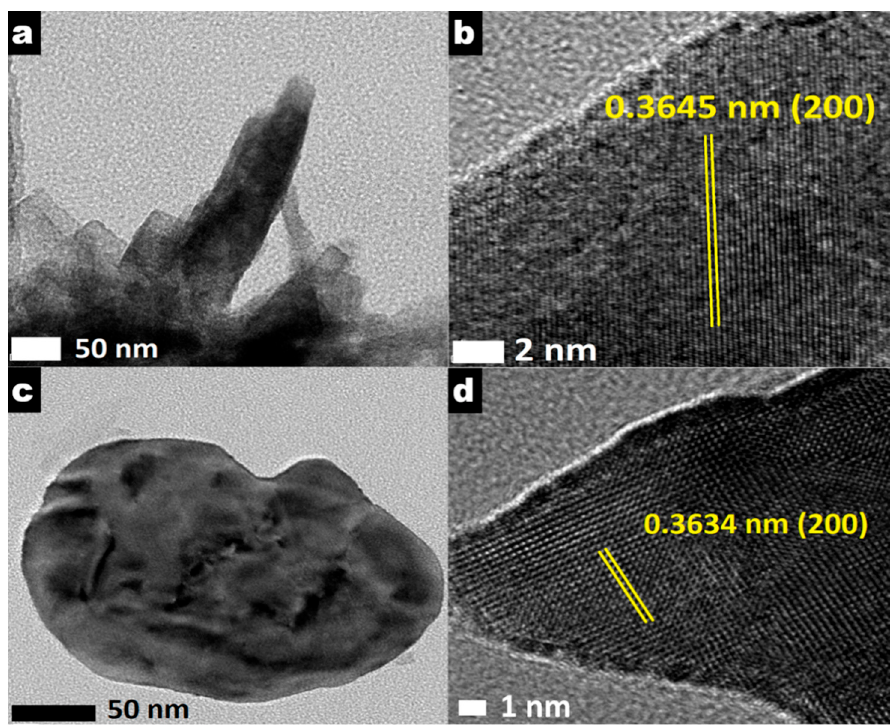
Figure 3. Low ( a ) and high ( b ) resolution TEM images of undoped WO 3 showing the d-spacing value of 0.3645 nm ascribed to [200] plane of monoclinic WO 3 . ( c ) Low- and ( d ) high-resolution TEM image of Sn-doped WO 3 exhibiting the d -spacing value of 0.3634 nm.